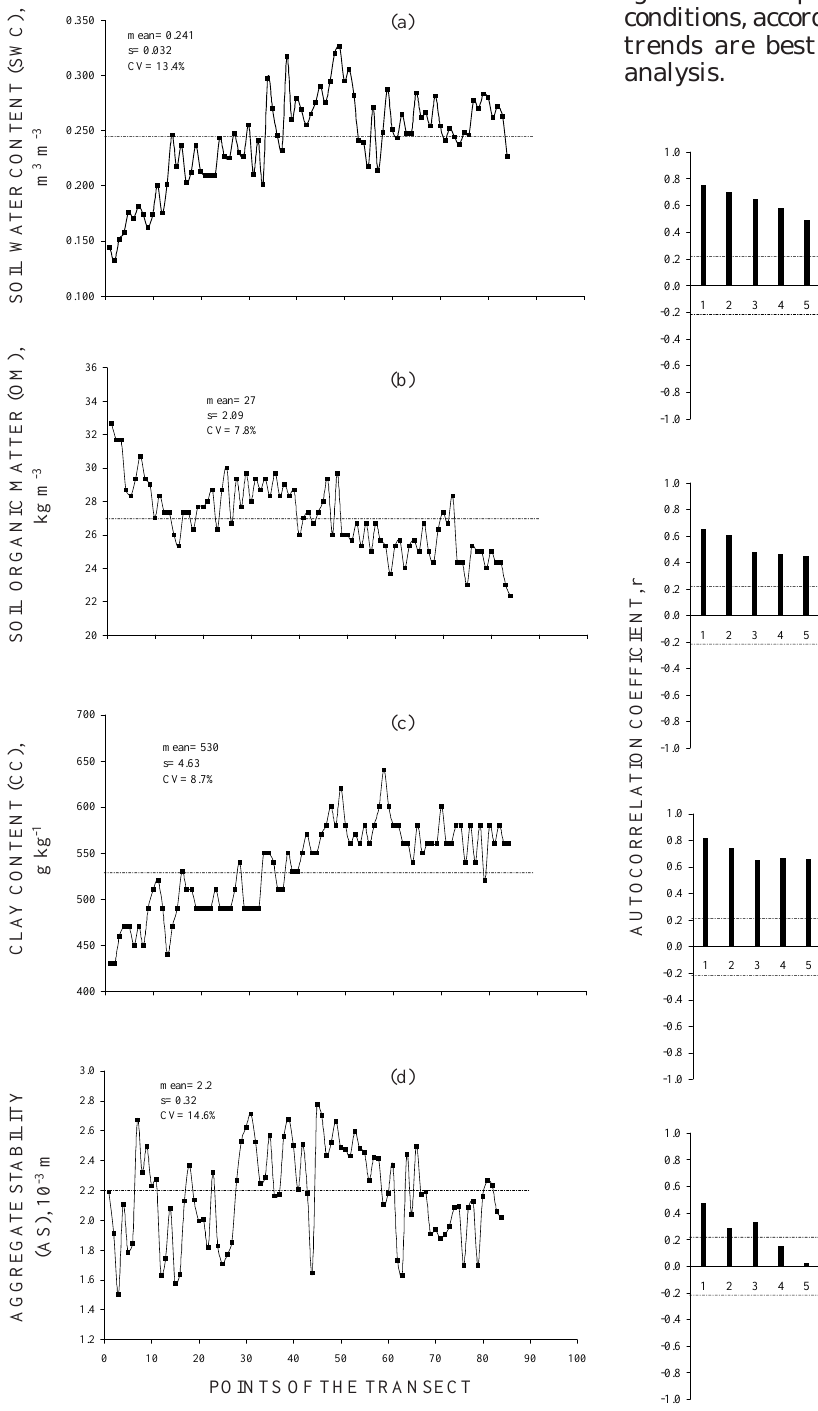
Figure 1. Soil water content on September 06, 1999 (a); soil organic matter (b); clay content (c); and aggregate stability distribution, meter by meter, along the 84 point transect (d).